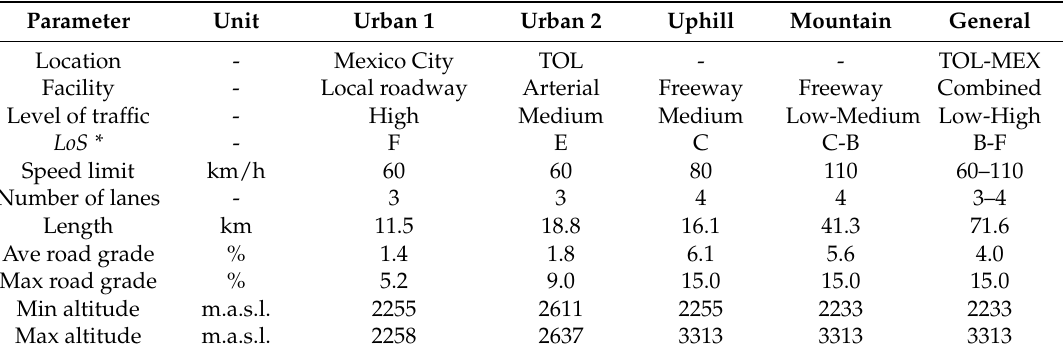
Table 1. Characteristics of the roads considered in this